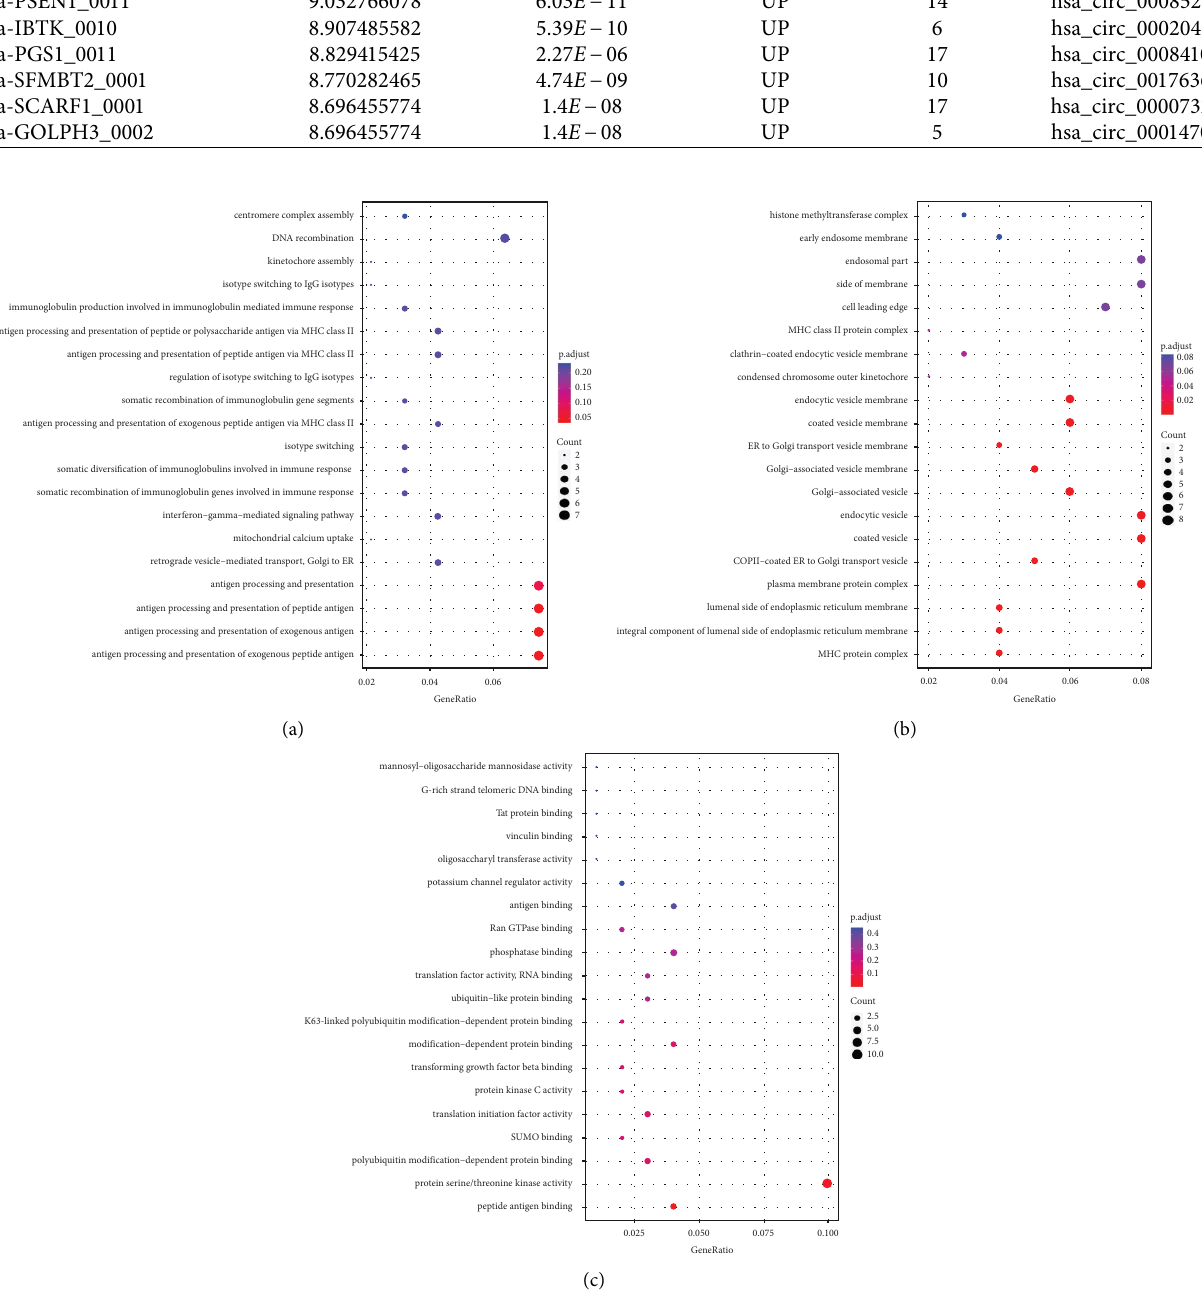
Figure 2: GO annotation of the host genes of the upregulated circRNAs. Te bar plot displays the gene numbers of the top 20 GO terms with signifcant enrichment in the (a) biological process, (b) cellular component, and (c) molecular function categories.